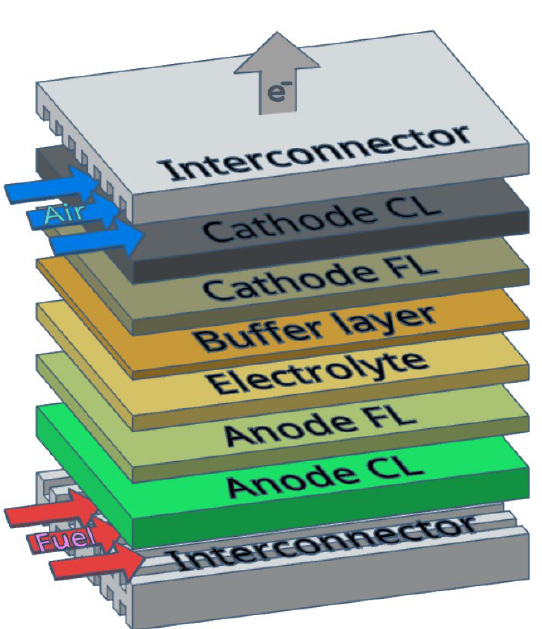
Figure 5. The typical components of a planar solid oxide fuel cell.